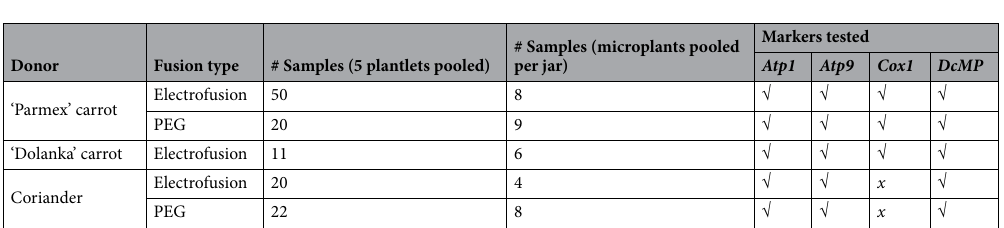
Table 5. Overview of the fusion derived samples, originating from Experiment 4 and 5, analysed with mitochondrial ( Cox1, Atp1 and Atp9 ) and chloroplast (DcMP) markers. The acceptor line was celeriac ‘Diamant’ in all cases. The number of analysed plants and the markers checked are indicated.